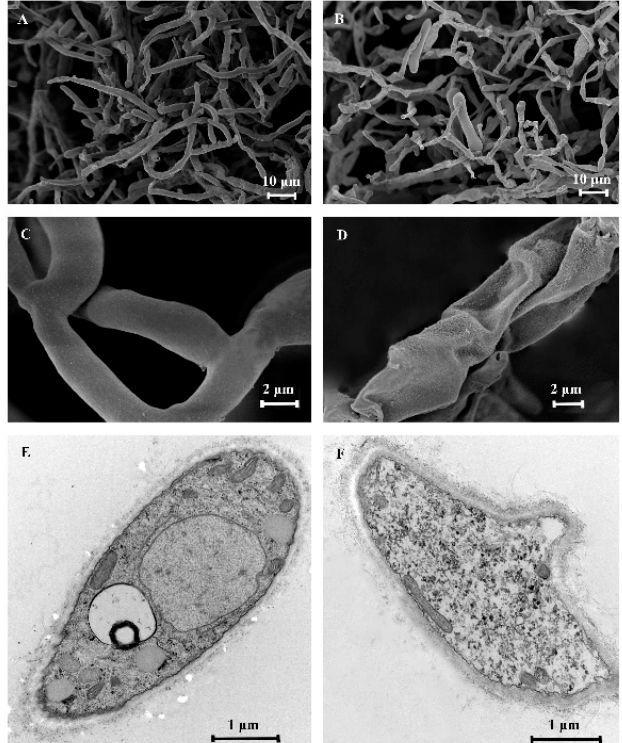
Figure 6. SEM of hyphal morphology ( A – D ) and TEM of hyphal ultrastructure ( E , F ) exposed to clove oil. ( A , C , E ) control, ( B , D , F ) treated with clove oil contact at 400 µ L / L.